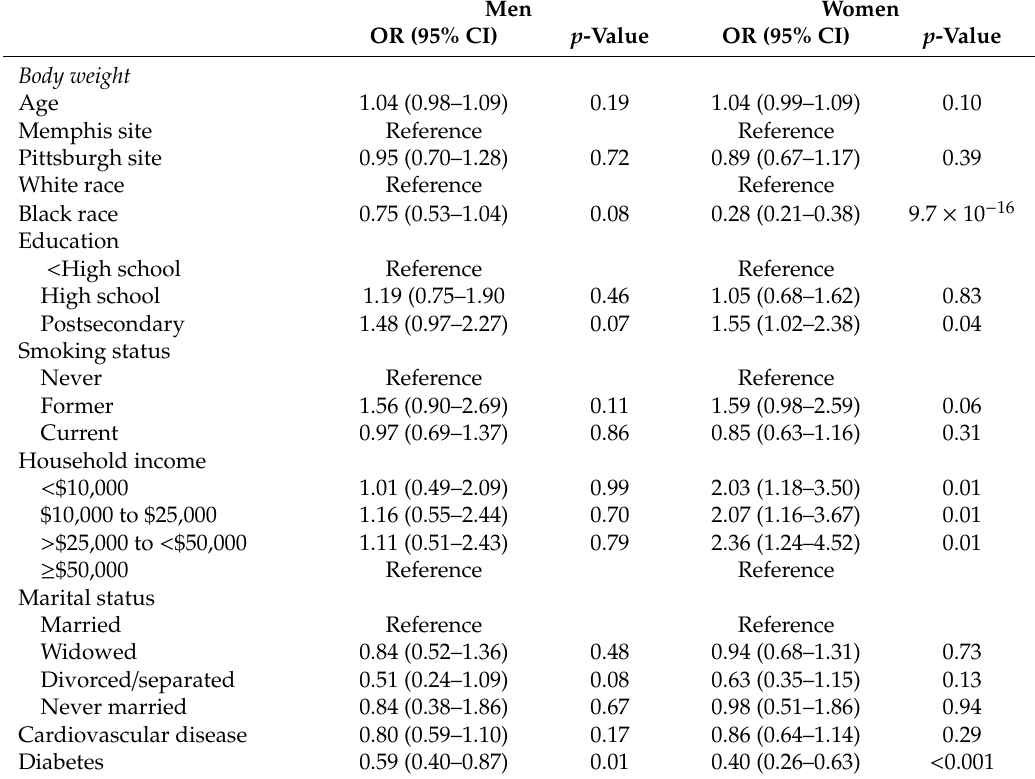
Table 5. Associations between adherence to individual cancer prevention guidelines and characteristics in the Health ABC Study by